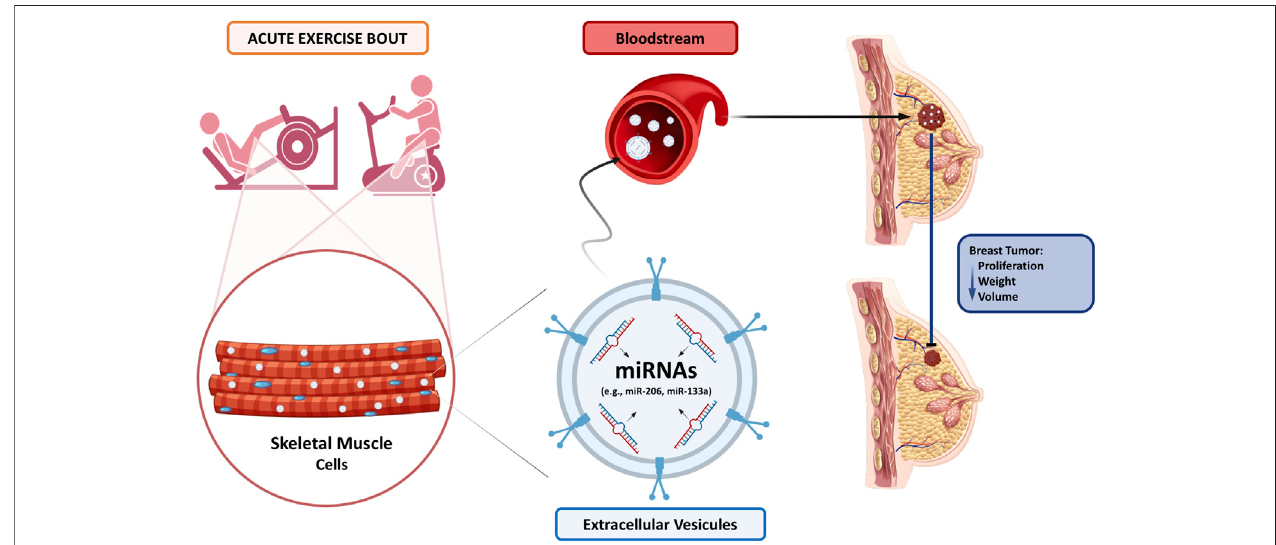
FIGURE 1 | Hypothesized mechanism of exercise training controlling the progression of breast cancer through the molecular crosstalk between skeletal muscle and cancer cells. In response to an exercise training bout, miRNAs are produced in the skeletal muscle and can translocate to the bloodstream inserted in extracellular vesicles, such as exosomes. c-miRNAs reach breast tumor through circulation and act as anti-cancer molecules, decreasing tumor proliferation, weight, and volume (Images from Freepik.com).